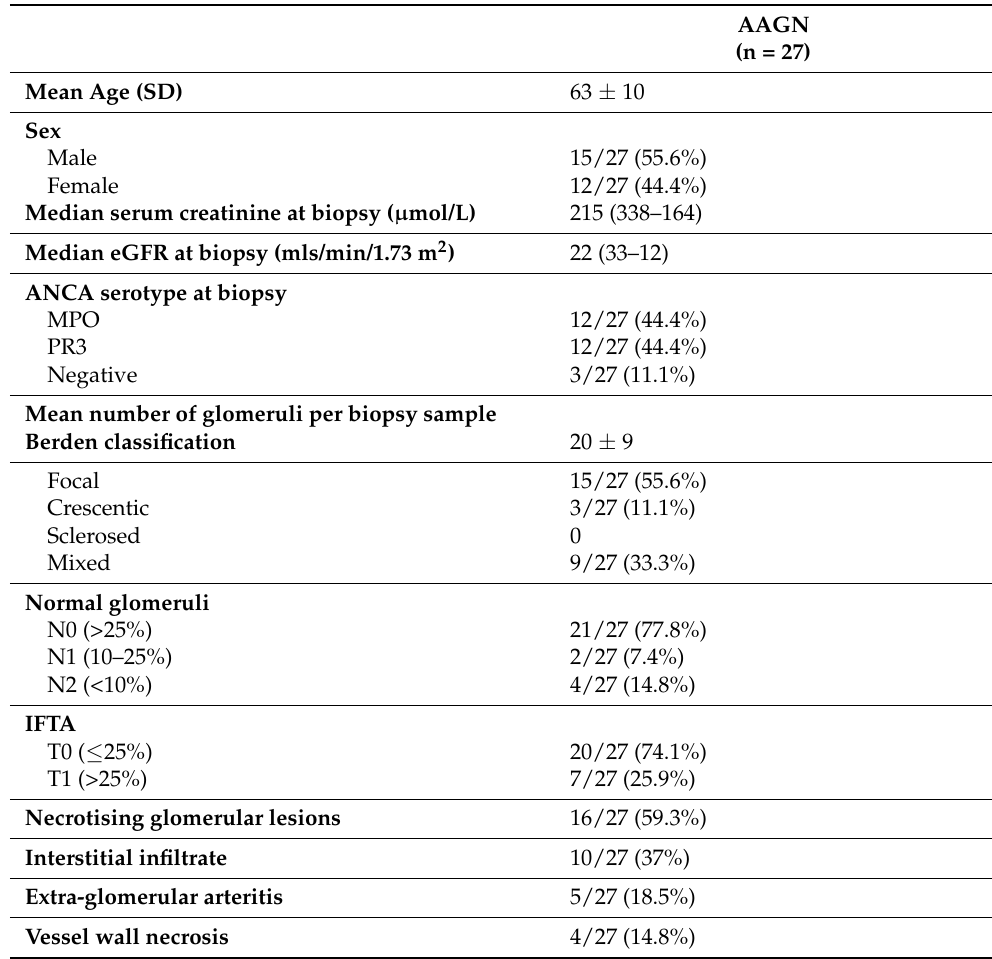
Table 1. Characteristics of study